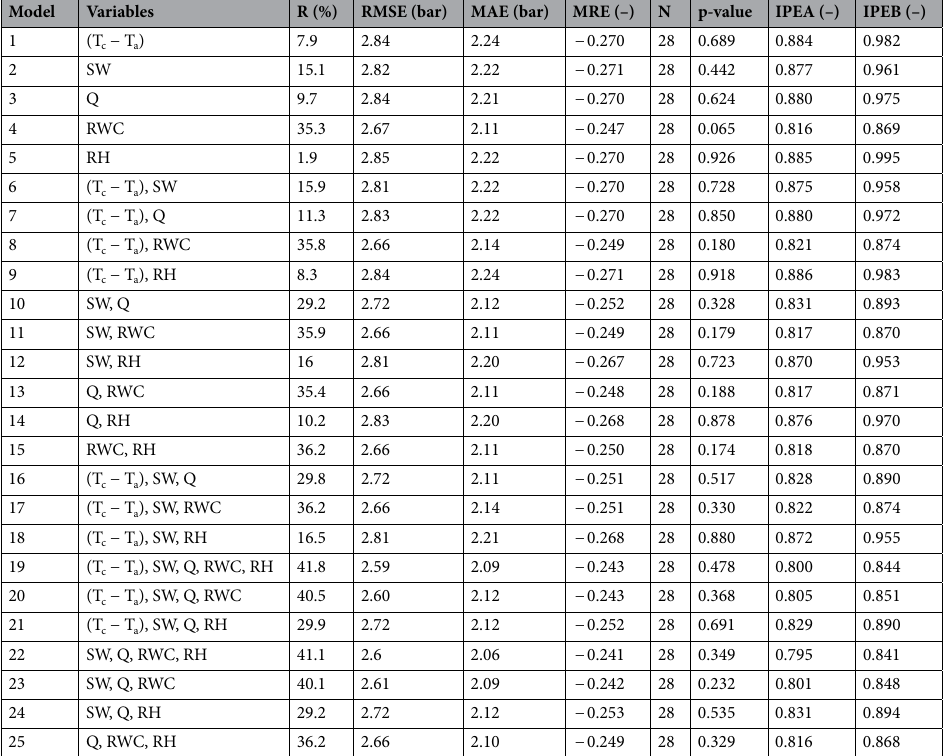
Table 13. Linear different models and statistical parameters for LWP estimating. R is correlation coefficient; RMSE: root mean square error; MAE: mean absolute error; MRE: mean relative error; IPE: Ideal Point Error; N is the number of